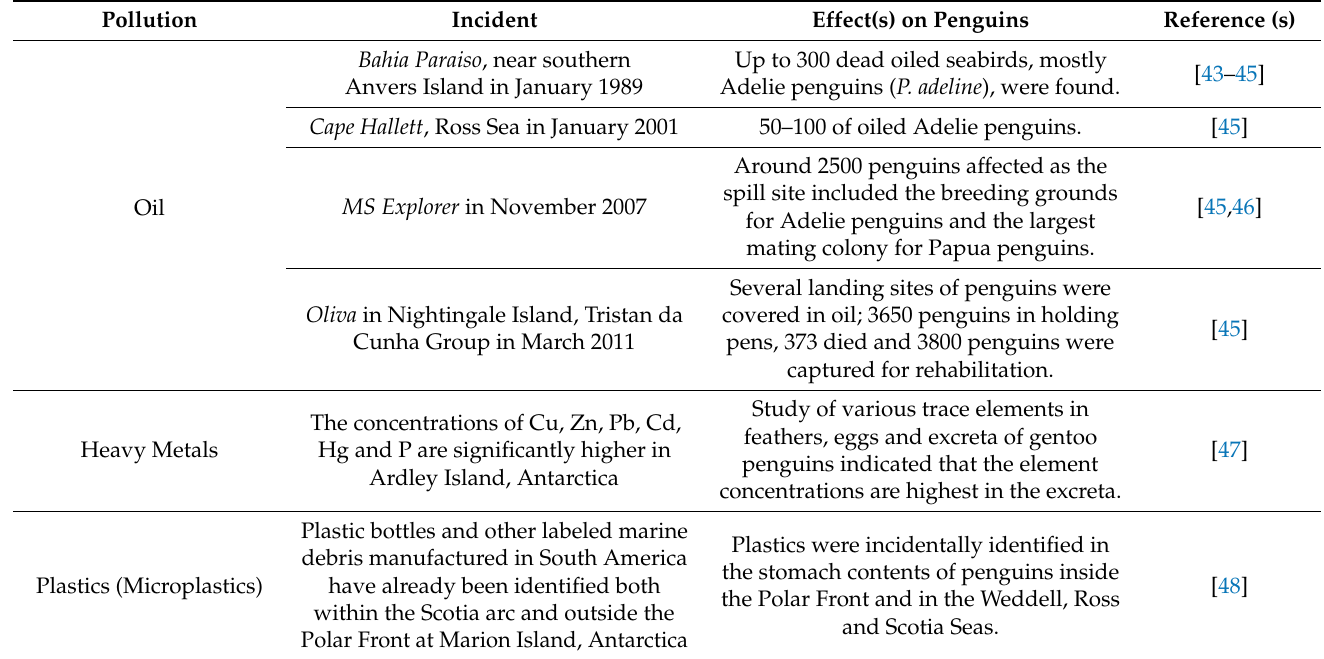
Table 2. Pollution incidents and their effects on penguins in